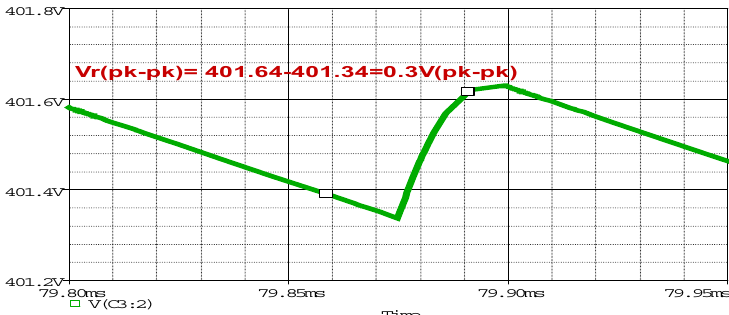
Figure 25. Magnitude of output voltage ripples for [7].